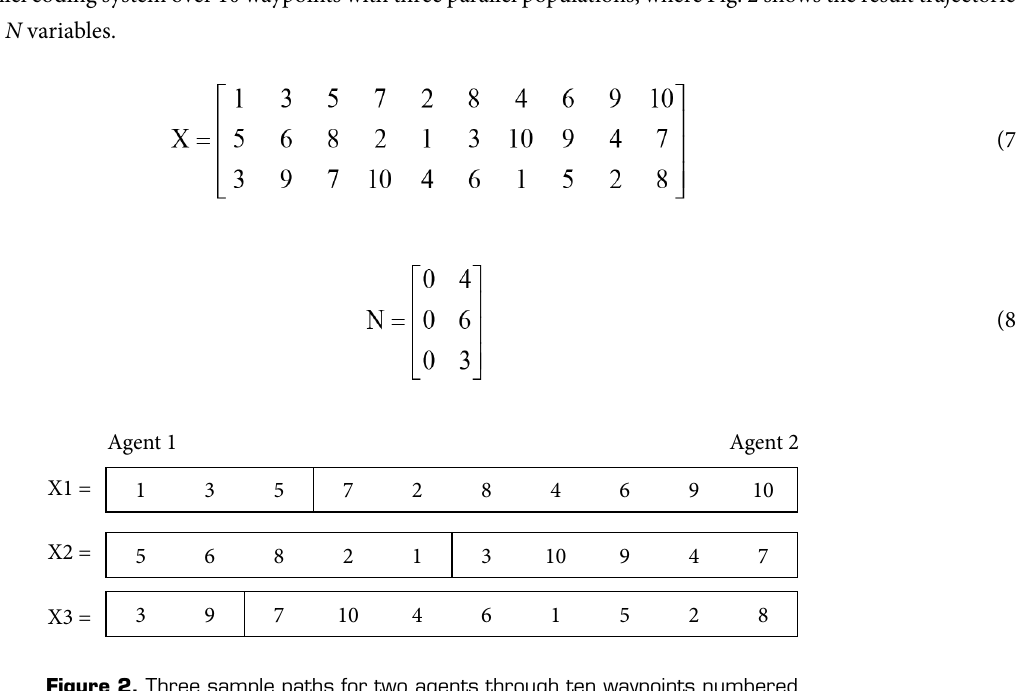
Figure 2. Three sample paths for two agents through ten waypoints numbered 1 to 10, modelized by the coding system Eq. (7) and